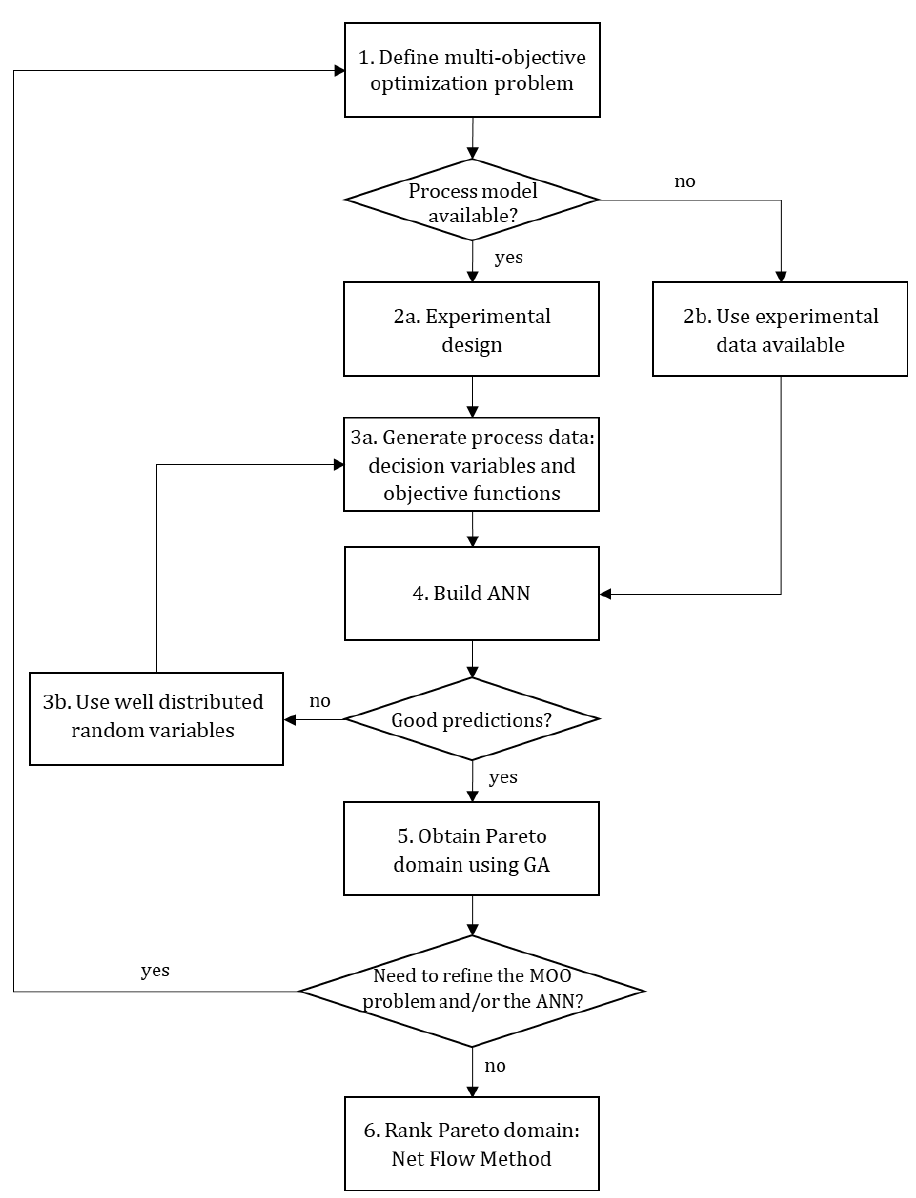
Figure 3. Flowchart of the proposed methodology for solving multi-objective optimization using a three-layer artificial neural network (ANN) as